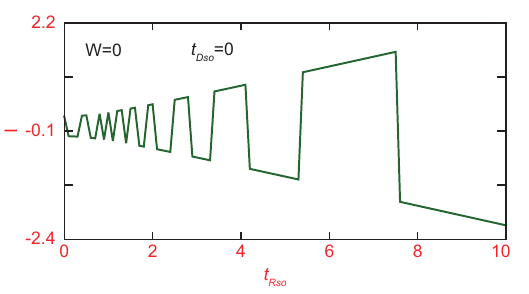
when t is fi xed Rso Dso